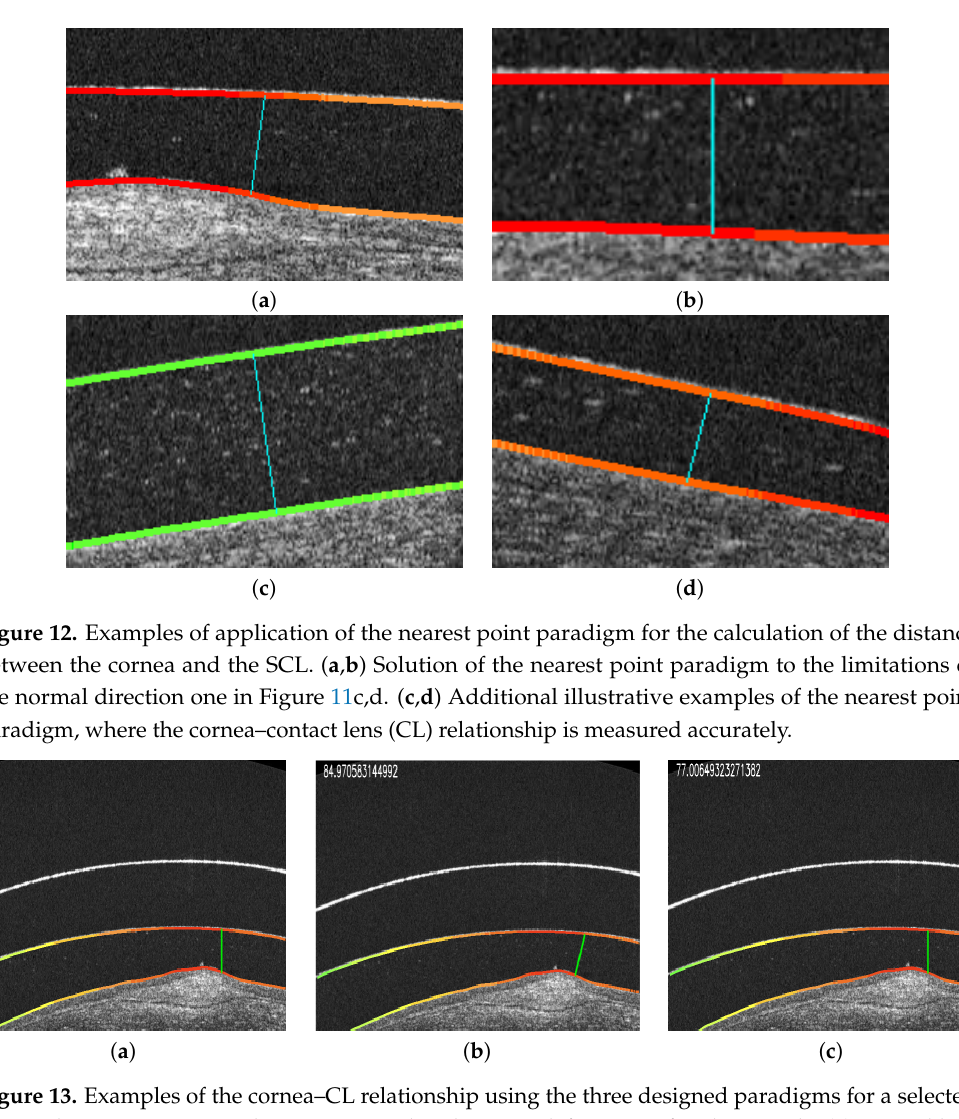
Figure 13. Examples of the cornea–CL relationship using the three designed paradigms for a selected point. The quantitative results are presented in the upper left corner of each example. ( a ) Vertical line. ( b ) Normal direction. ( c ) Nearest